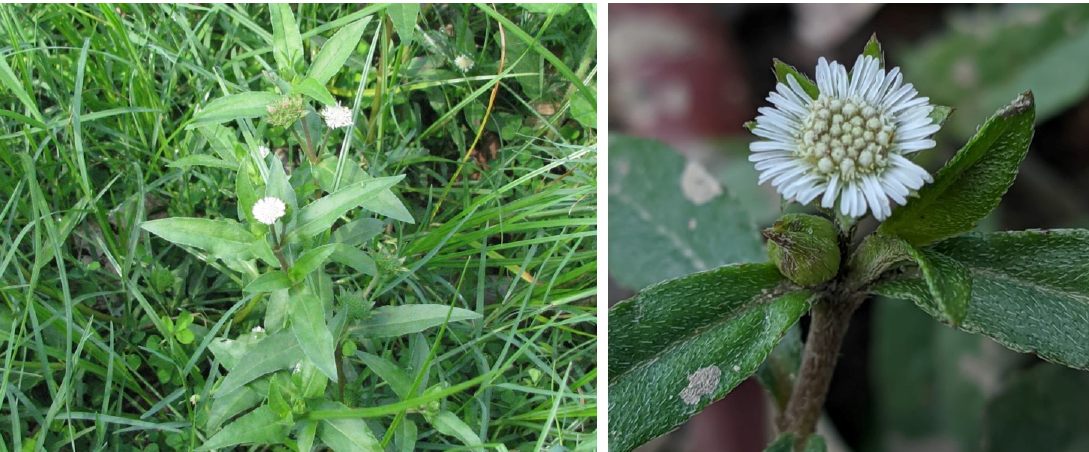
Figure 1. Photographs of Eclipta prostrata (Photos by Basu Dev Neupane, used with permission).